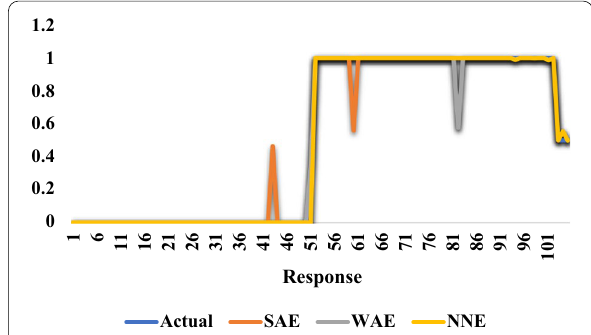
Fig. 7 Response plots of the ensemble models